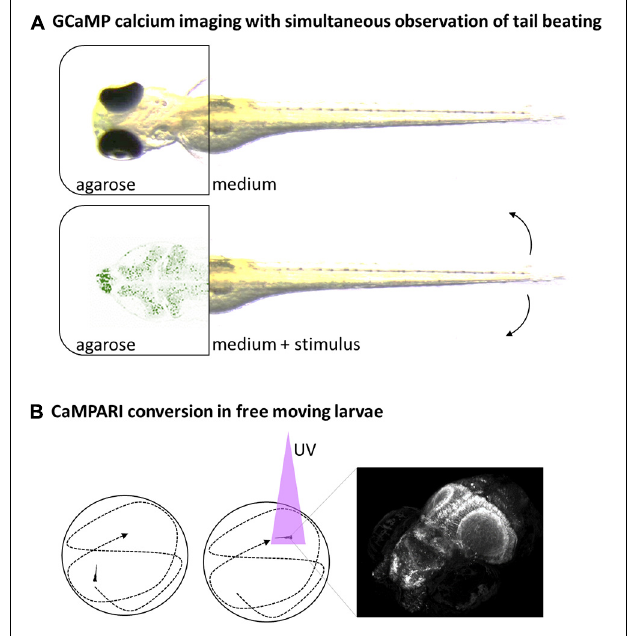
FIGURE 2 | Schematic overview of selected neuroimaging methods. (A) Head-fixed larvae can be analyzed for neuronal activity via fluorescent Calcium-reporters like GCaMP expressed in the brain and simultaneous observation of tail beats in bright field movies. (B) Neuronal-specific expressed CaMPARI can be used to take a snapshot of current brain-activity in free-swimming larvae by a short burst of UV-light that facilitate conversion of CaMPARI in the presence of calcium only (left and middle). The CaMPARI converted from green to red can be imaged afterward in high resolution, revealing the neuronal activity pattern at a defined timepoint